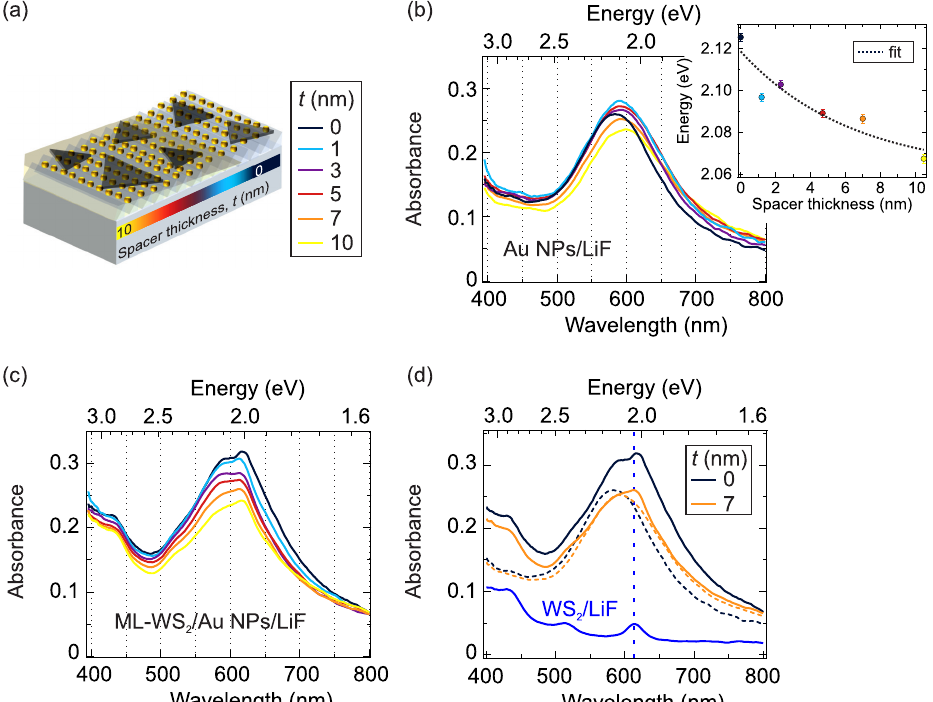
Figure 2. ( a ) Sketch of the sample. The plasmonic substrate is composed of Au NP chains elongated along the grooves of the LiF substrate. A LiF dielectric layer with a thickness ( t ) gradient (from zero (black) up to 10 nm (yellow)) is interposed between the Au NPs and the WS 2 flakes, which are spread on the plasmonic substrate. For the graphs of panels ( b – d ) the same color code reported in the legend (from black to yellow in the 0-10 nm t range) is shown. ( b ) Micro-absorbance spectra of Au NPs/LiF as a function of t . In the smaller graph the energy position of the Au LSPR as a function of t reported and fitted by means of an exponential function (black dashed curve). ( c ) Micro-absorbance spectra of the ML-WS 2 /Au NPs heterostructure as a function of t . ( d ) Comparison between the absorbance of the hybrid system in absence of the LiF spacer (solid black) and in the presence of a 7 nm thick spacer (solid orange). The dashed curves are the corresponding absorbance spectra of the Au NPs/LiF. The solid blue line is the spectrum of WS 2 /LiF, with the energy position of the A exciton marked by the vertical blue